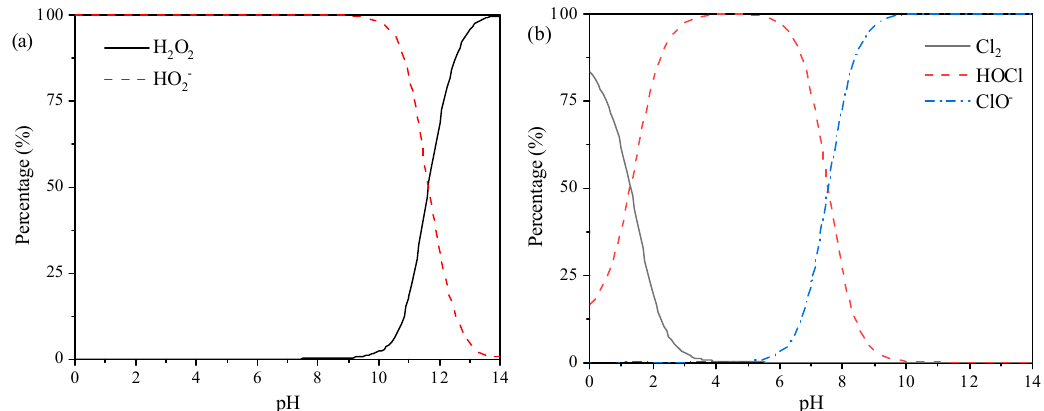
Figure 1. Distribution of main species in H 2 O 2 ( a ) and NaClO ( b ) solutions as a function of pH at 25 °C and for C (H 2 O 2 ) T = C (NaClO) T = 500 mg/L.